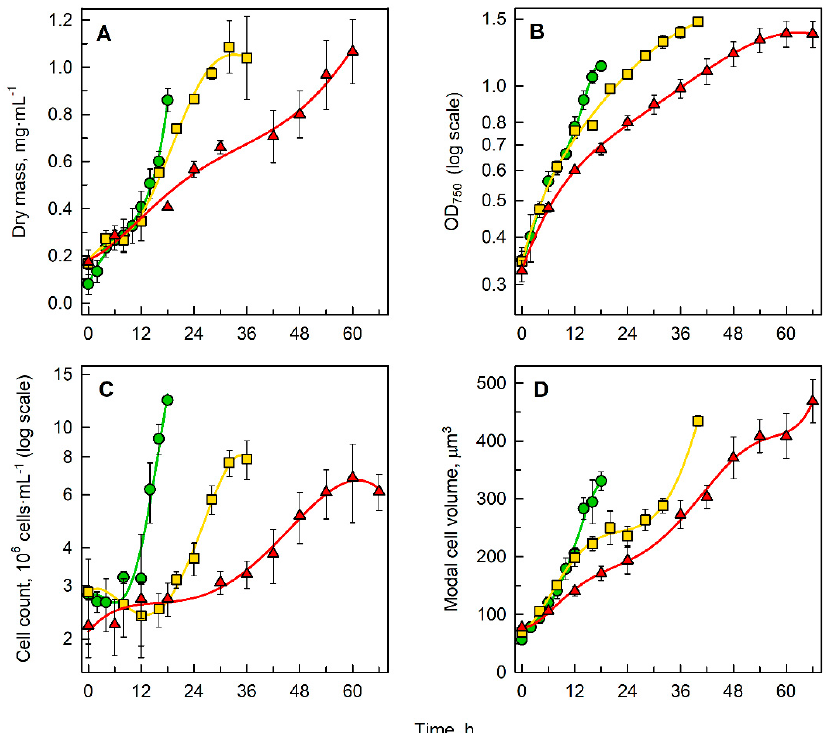
Figure 2. Changes in dry mass ( A ), optical density at 750 nm ( B ), cell count ( C ) and cell volume ( D ) of C. reinhardtii grown in 0% D 2 O (green circles), 70% D 2 O (yellow squares) or 90% D 2 O (red triangles). All cultures were grown and sampled for the duration of one cell cycle. OD: optical density.